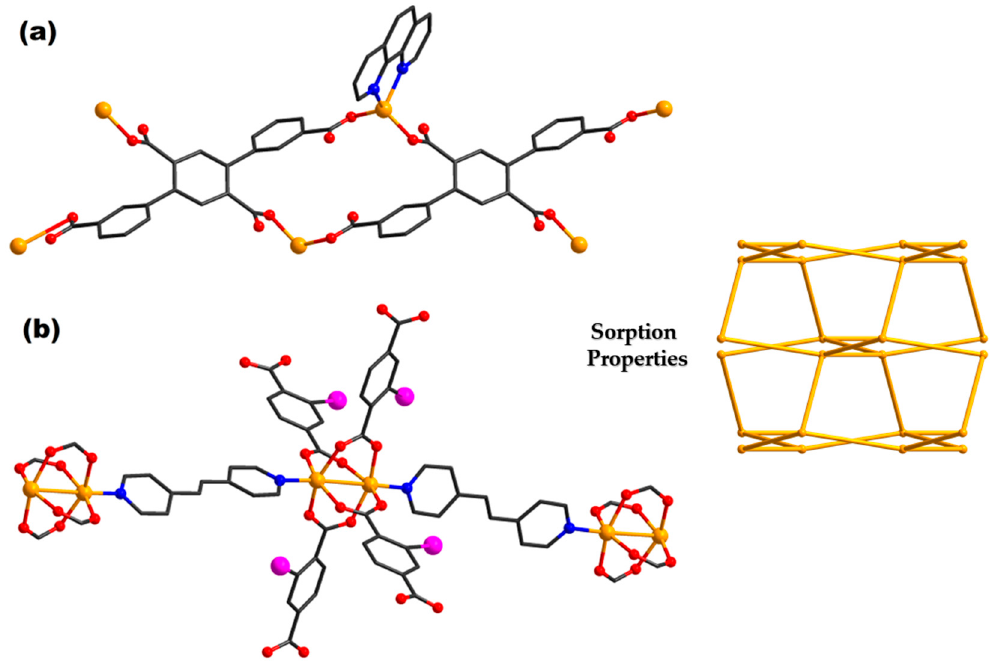
Figure 5. Structures of complexes {[Zn(tptc) 0.5 (phen)]·dioxane} n ( 103 ) ( a ) and [Zn 2 (2-I-Pht) 2 bpa] n ( 112 ) ( b ) (adapted from ref. [114,122]). Another CP, {[Zn 3 (pzdc) 3 (vim) 6 ]·vim·2H 2 O} n ( 104 ) (H 2 pzdc = pyrazine-2,3-dicarbox-